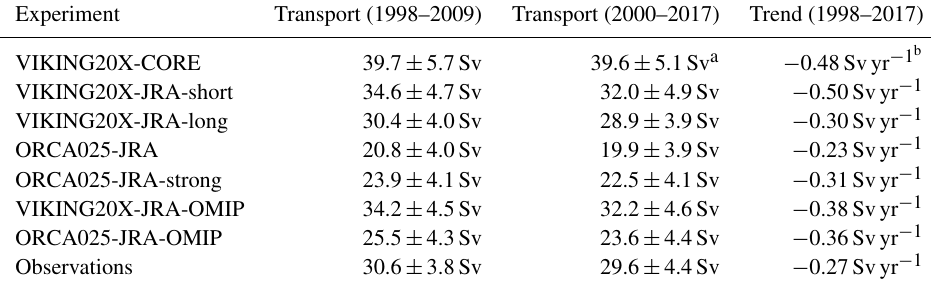
Table 5. DWBC export (mean and standard deviation) across 53 ◦ N for different periods, characterised by the NADW defined by σ 2 criteria (ORCA025-JRA > 36 . 52, ORCA025-JRA-strong > 36 . 63, VIKING20X-JRA-long > 36 . 59, VIKING20X-JRA-short > 36 .